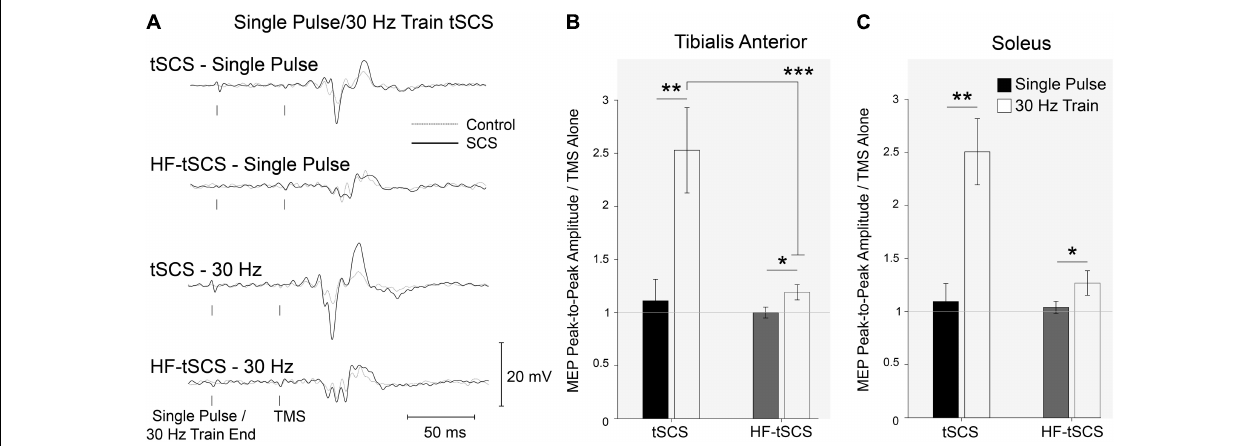
FIGURE 7 | The effects of two separate waveforms (Traditional tSCS and High-frequency tSCS). (A) Example waveform average (20-control, 10-conditioned trials) EMG responses evoked in the TA from single participant under control (gray dashed line) and tSCS/HF-tSCS conditioned (solid black line) with single pulses or 30 Hz trains. Normalized peak-to-peak MEP amplitudes in tSCS and HF-tSCS waveform conditions in the (B) TA and (C) Sol muscles at interstimulus intervals. Mean ± SEM; * P < 0.05; ** P < 0.01; *** P <